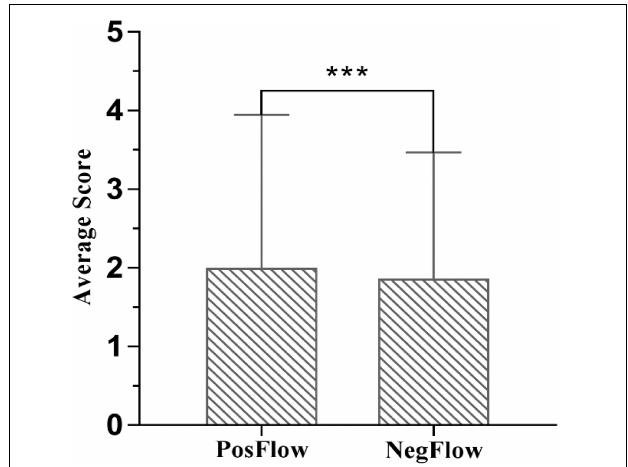
FIGURE 3 | A comparison of average PosFlow and NegFlow